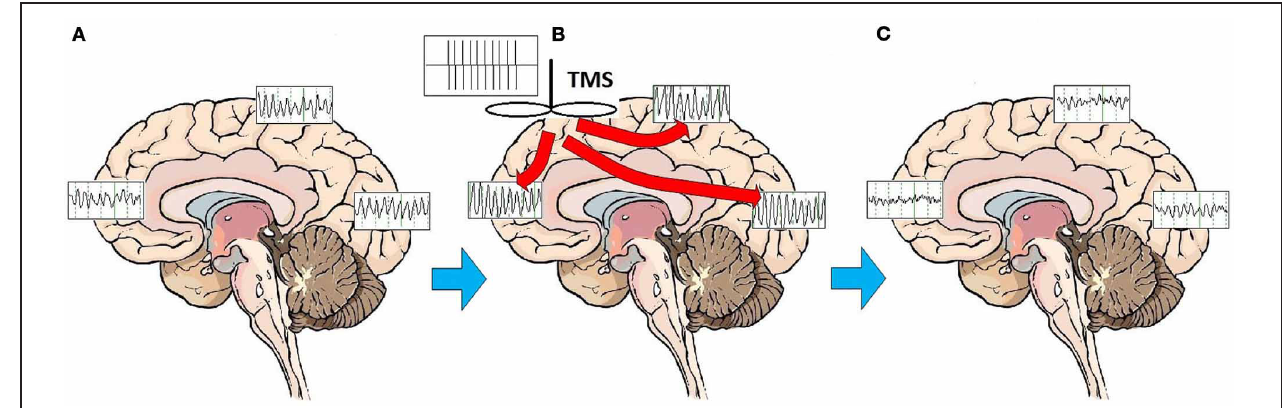
FIGURE 1 | Effects of rTMS stimulation on brain function. On average, patients with MDD exhibit a broad pattern of highly synchronous theta and alpha activity over most brain regions (A) . rTMS administered as a train of high amplitude pulses at a frequency of 10Hz entrains brain oscillatory activity to the frequency of stimulation, for the duration of the stimulation